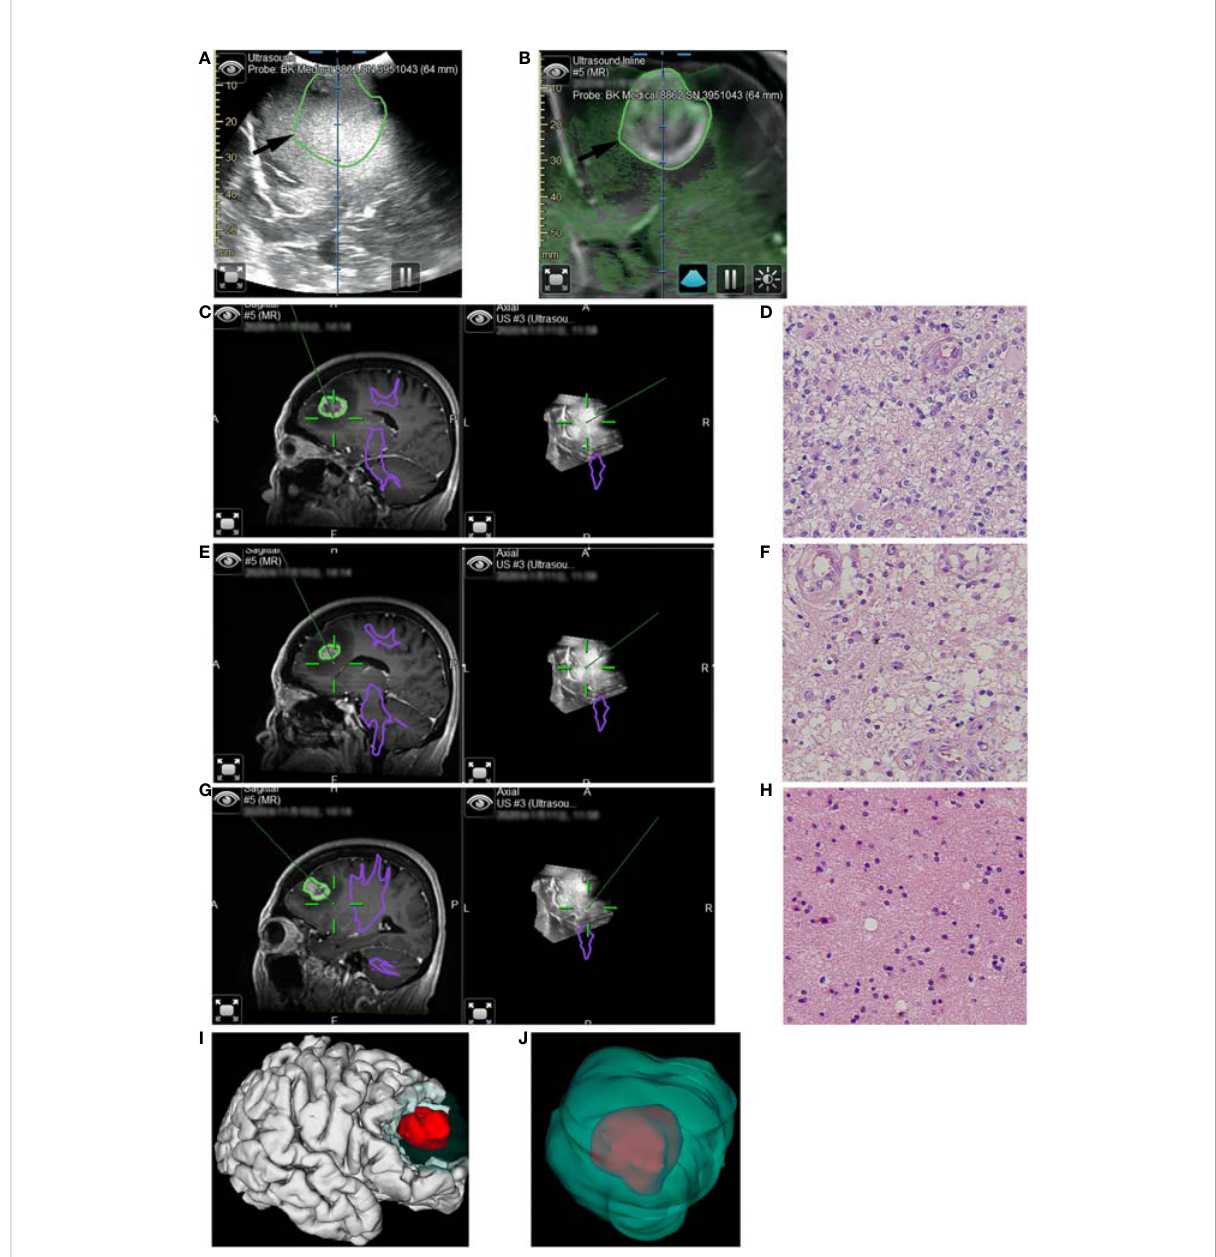
FIGURE 3 Illustrative case 2. (A) The pre-resection iUS image was registered with MRI using navigation. (B) Overlay of iUS image on coplanar MRI images. The black arrows indicated the border of the enhanced tumor on T1+C images. Compared to the enhanced tumor, the hyperechoic area was larger. (C) The fi rst tissue sample was taken during resection of the enhanced tumor. On the co-planar 3D iUS, this part was hyperechoic. (D) Hematoxylin and eosin (H&E) stain (×40) showed marked hypercellularity, cellular and nuclear atypia, increased mitotic fi gures, and hypervascularity. (E) The second tissue sample was taken outside the enhanced lesion, where MRI showed an abnormally long T1 signal. Co- planar 3D iUS showed a similar signal at this site as the enhanced part. (F) H&E stain (×40) demonstrated the same characteristics as image D, revealing moderate in fi ltrative growth of tumor cells. (G) the third sample was taken after all tissue with abnormal MRI signals had been removed. At this site, the iUS were still hyperechoic but slightly lower than the previous site. (H) H&E stain (×40) demonstrated the microstructure of white matter, with mild gliosis and nuclear atypia. (I, J) 3D reconstruction based on iMRI images. The removed tissues with hyperechoic signals were segmented as green volumes, which measured 60.6cm 3 . As a comparison, the enhanced part was segmented as red volume, which was only 8.1cm 3.